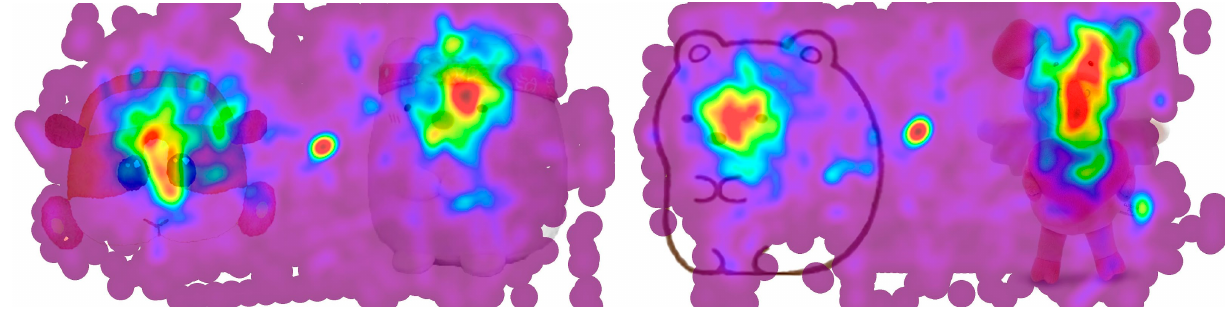
Figure 4. Illustration of the eye tracker heat map. The data are the combination of all subject eye tracker observation lengths for the same doll picture. Left: P1-2 vs. P2-3; Right: P2-2 vs. P3-3. The eye tracker feature distribution of the eye region on soothing doll pictures is shown in Table 6. There were significant differences between 2D and 3D pictures, either on stage 1 or stage 2, for both observation length and observation count features. Compared with the whole doll, the observation duration ratio of 3D was also higher than the 2D ratio. Table 6. Eye tracker results of AOI around the eyes. The data were derived from AOI-3 and AOI-4. Observation Length